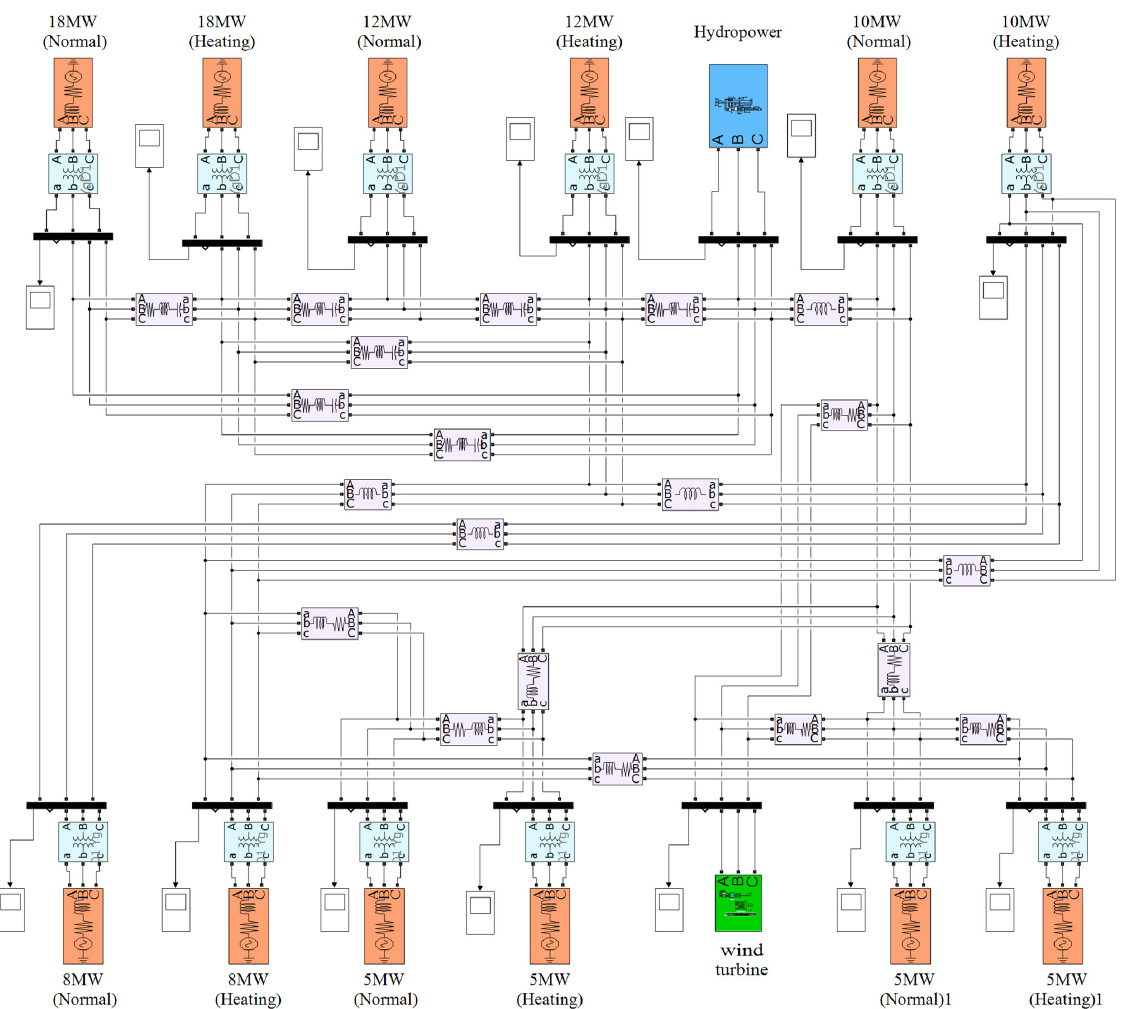
Figure 9. Case study of IEEE 14 Bus Power System. This power model consists of twelve coal-fired generators, a 30 MW hydropower generation system, and a 9 MW wind power system.